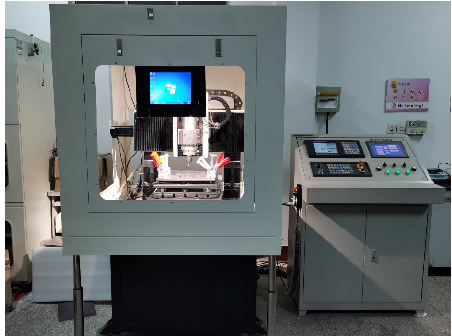
Figure 1. HRFSW machine is required for testing.